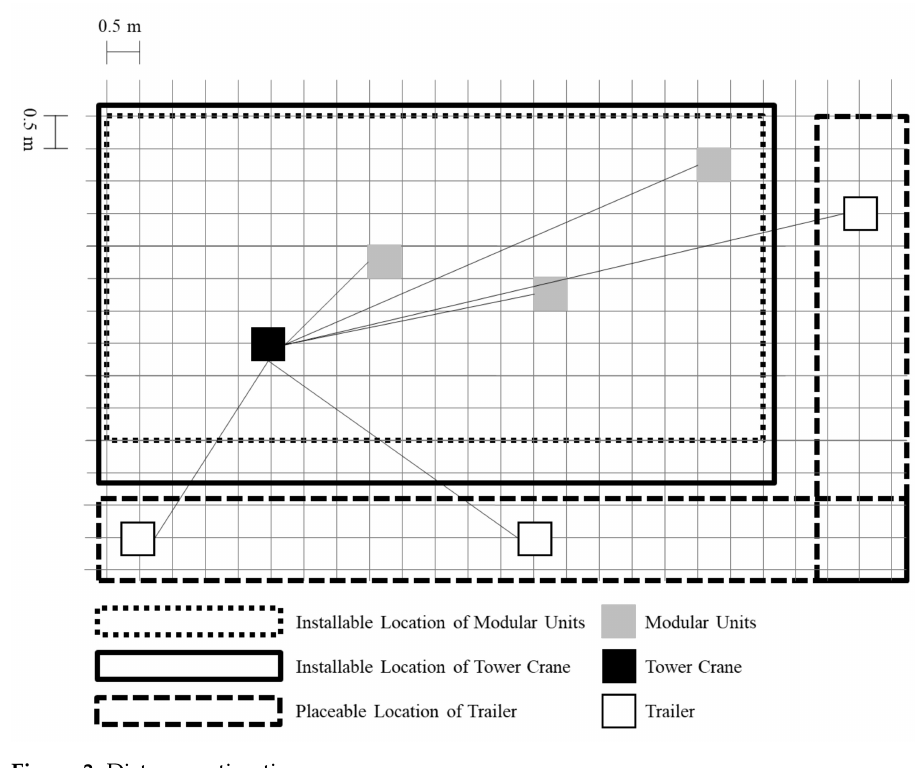
Figure 3. Distance estimation.